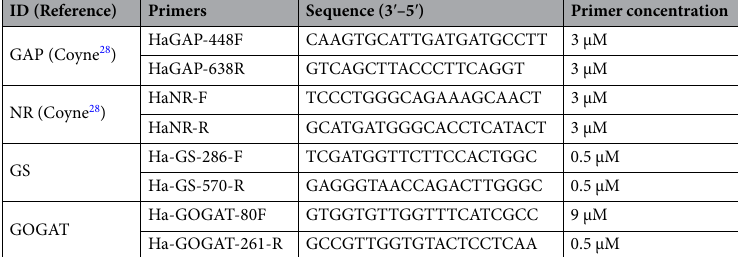
Table 2. Primer sequences and concentrations for